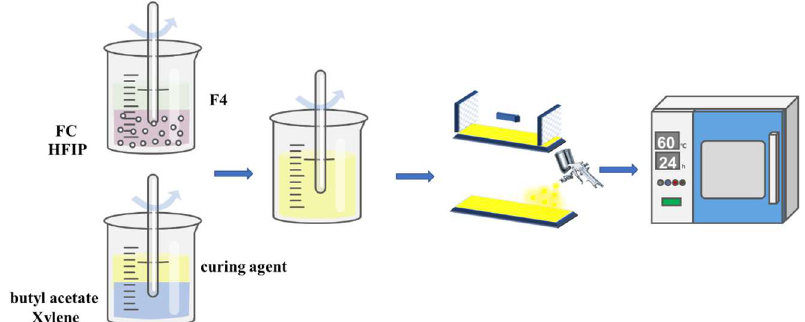
Figure 2. Composite coating preparation process.